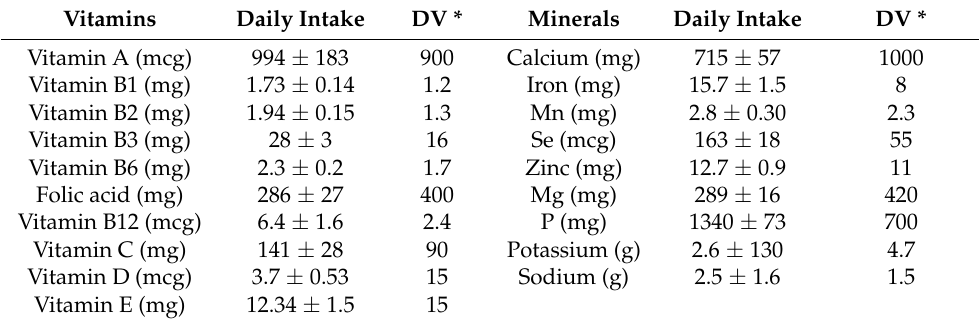
Table 3. Micronutrient daily intakes in marathon